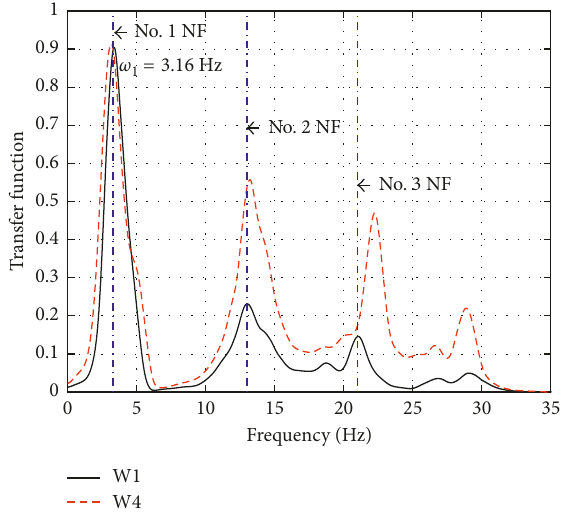
Figure 11: Transfer function of model under white-noise input. W1 and W4 are the test conditions given in Table 2, and NF is the natural frequency of the structure determined by SAP2000